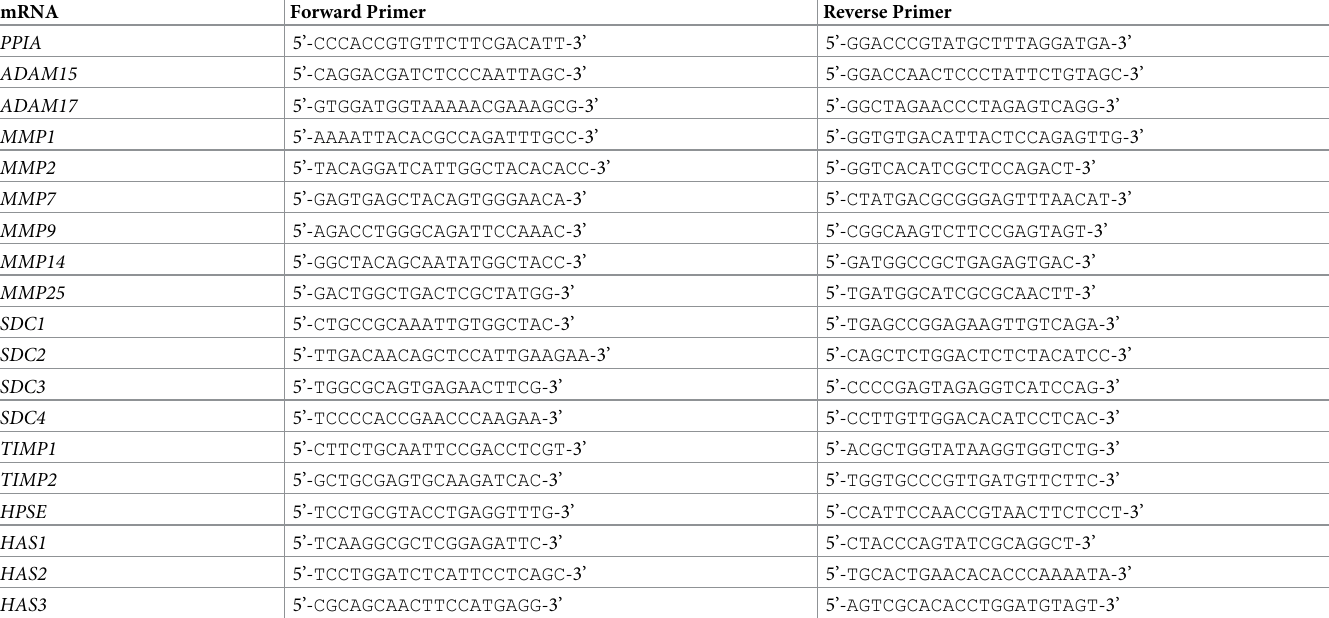
Table 1. Primer sequences used for